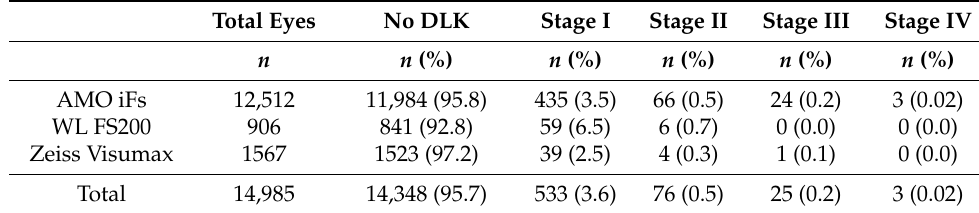
Table 2. DLK incidence after LASIK by femtosecond